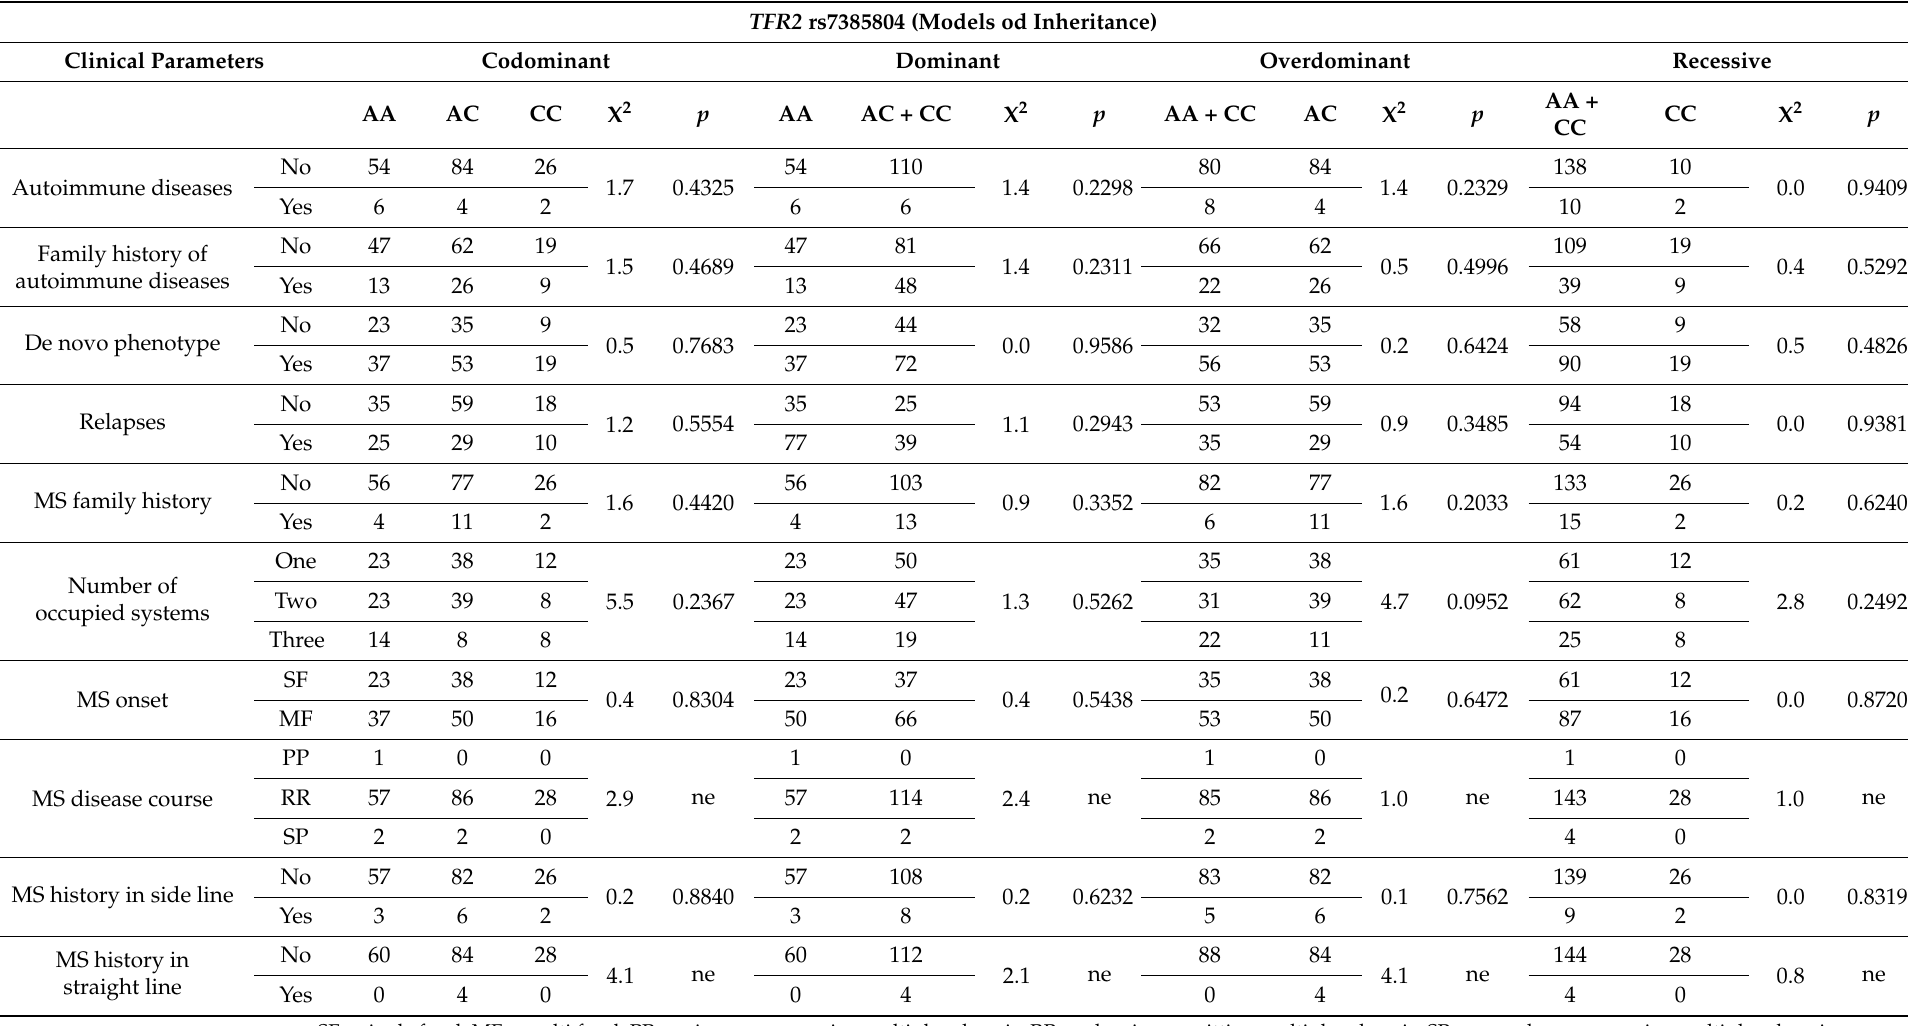
Table 10. Analysis of the relationship between the rs3811647 TFR2 polymorphism and selected clinical parameters. TFR2 rs7385804 (Models od